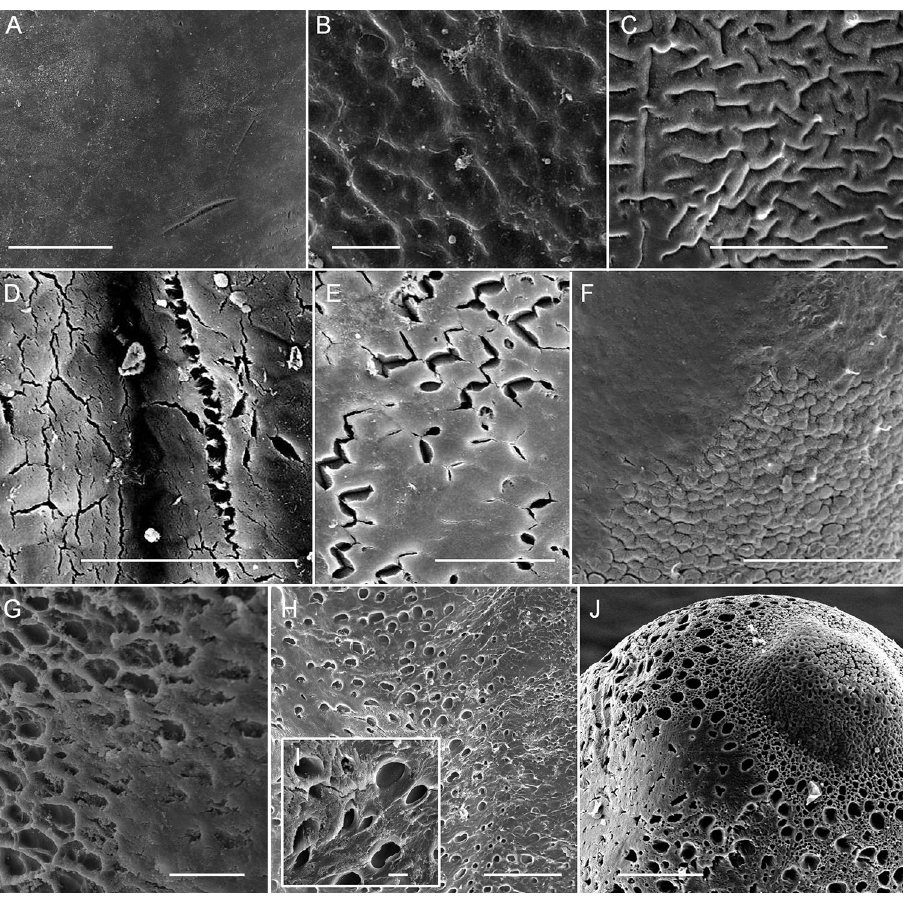
Figure 5. Morphological variation of the cuticle that may result from mucus. A Smooth cuticle B–C Wrinkled cuticle D–E Cracked surface of cuticle F Areole-like structures on the anterior end of the cuticle G–J Indentations on the G–I mid-body and J anterior end of the cuticle surface. Scale bars 100 µm ( A ), 10 µm ( B ), 50 µm ( C–E ), 100 µm ( F ), 20 µm ( G ), 100 µm ( H ), 10 µm (I), and 100 µm ( J